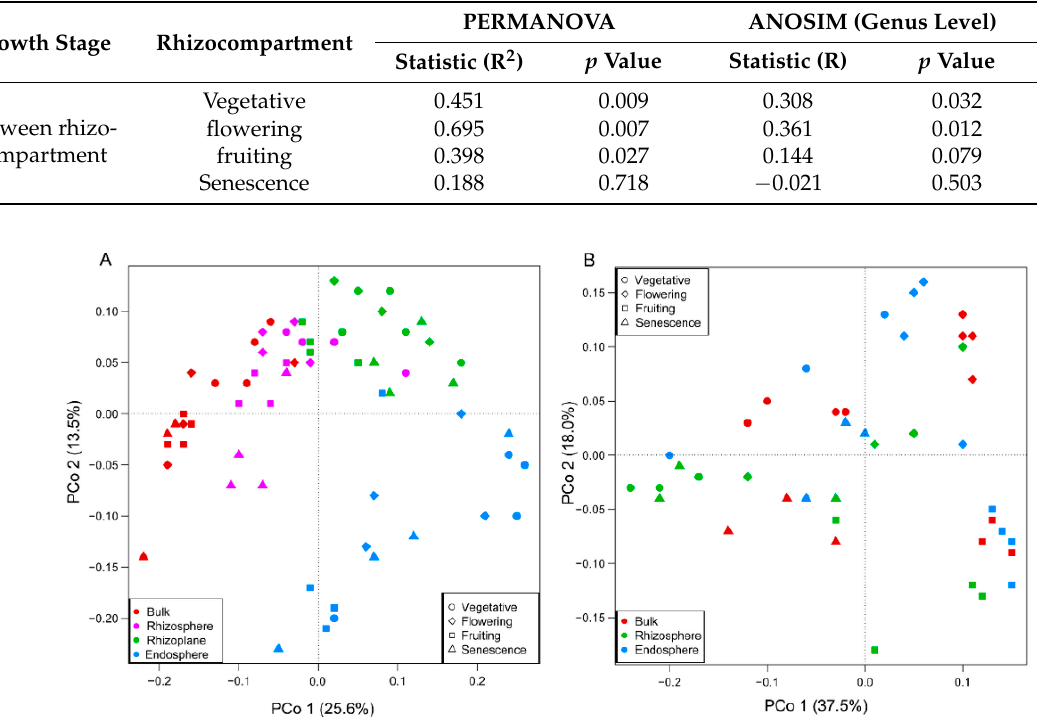
Figure 3. PCoA using the WUF metric indicates that the largest separation between the microbial communities is spatial proximity to the root compartment for bacterial communities ( A ) and growth stage for fungal communities ( B ). The circle, square, triangle, and diamond symbol represents samples collected from different growth stage; red, pink, green and blue colored symbols represent different rhizocompartment. Color and symbol combination represents rhizocompatrment samples in each growth stage.